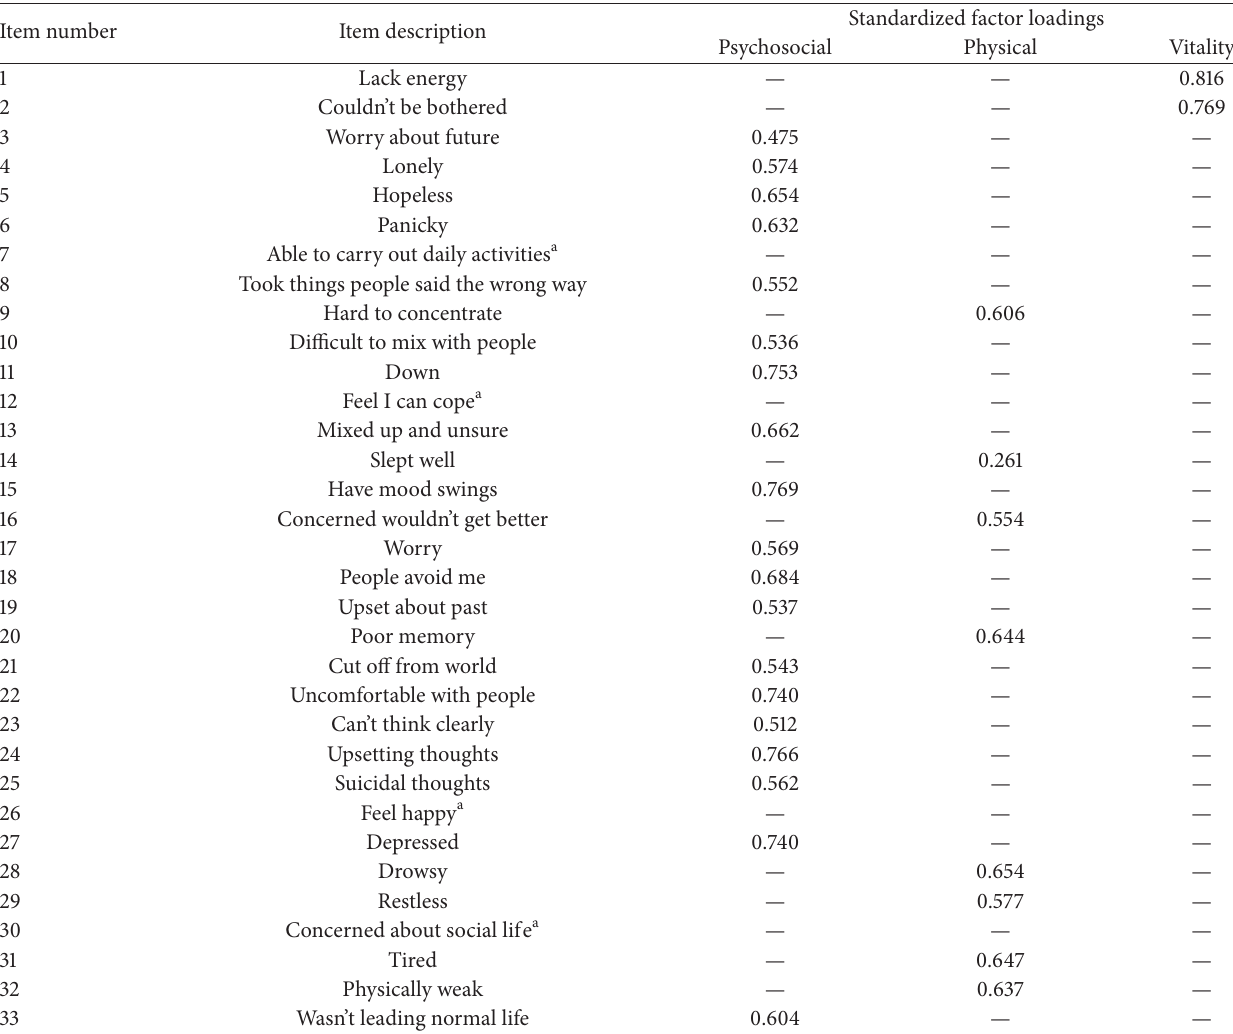
Table 3: Standardized factor loadings on SQLS-R4 with three underlying